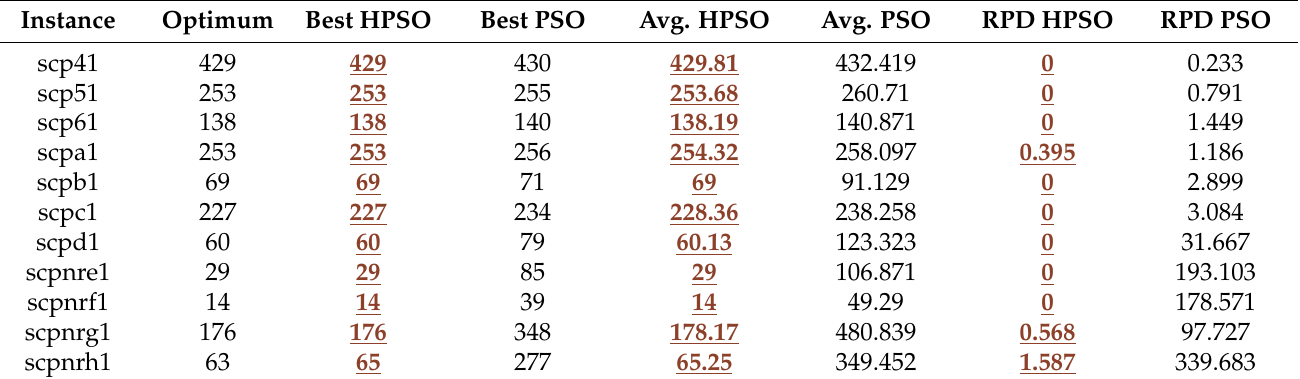
Table 3. Comparison of results between PSO and HPSO.